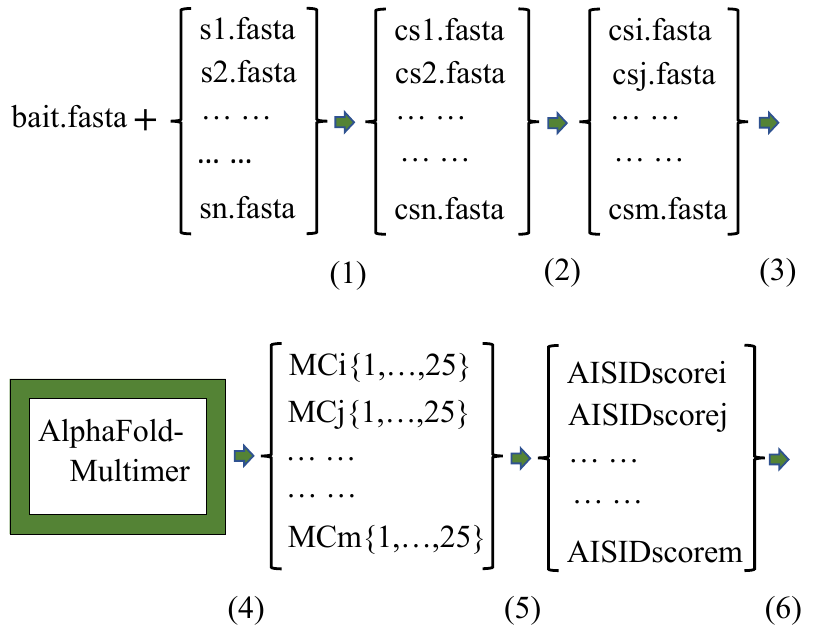
Figure 3. Workflow diagram of specific protein binding screening: ( 1 ). Create a list of composite sequence files of FASTA-format. Each file contains two separate sequences, one is that of the bait protein, the other is from one of the ligand proteins against which to be screened. ( 2 ). Sort the list by the number of amino acid residues in the composite sequence files from small to large. ( 3 ). Through a load-balanced scheduler, submit the batch jobs onto the server running the AlphaFold-multimer. ( 4 ). Once the project finishes, each job generates 25 predicted heterodimer complex structure models. ( 5 ). Harvest outputs and calculate the AISIDscore for each bait-ligand pair, resulting in a list of AISIDscores for the screening project. ( 6 ). Sort the list by AISIDscore from large to small for evaluation.